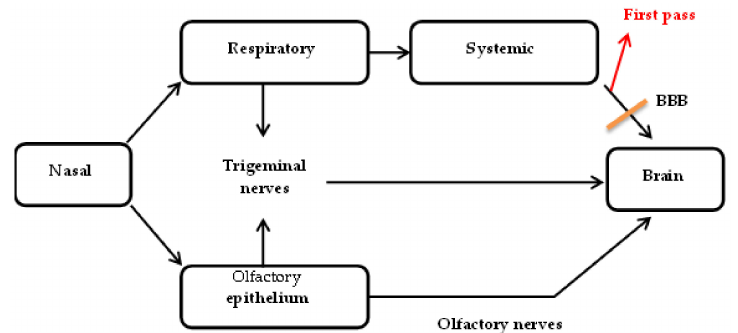
Figure 3. Potential transport of API from the nasal cavity to the brain (Adapted with permission from [61]. Copyright 2022, copyright holder Elsevier,